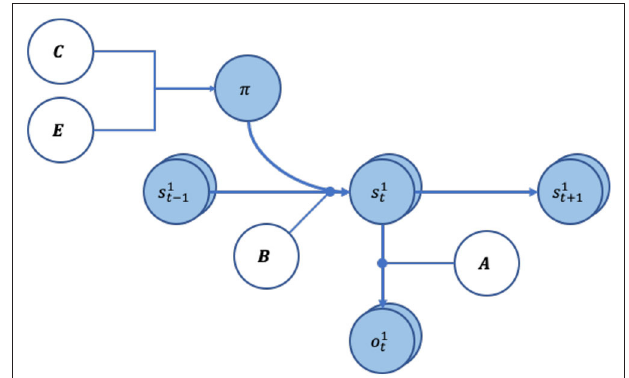
FIGURE 1 | Graphical representation of the generative model. The arrows indicate conditional dependencies, with the endpoint being dependant on where the arrow originated form. The variables in white circles show priors, whereas variables in light blue circles are random variables. The A and B matrices have round arrowhead to show they encode the transition probabilities between the